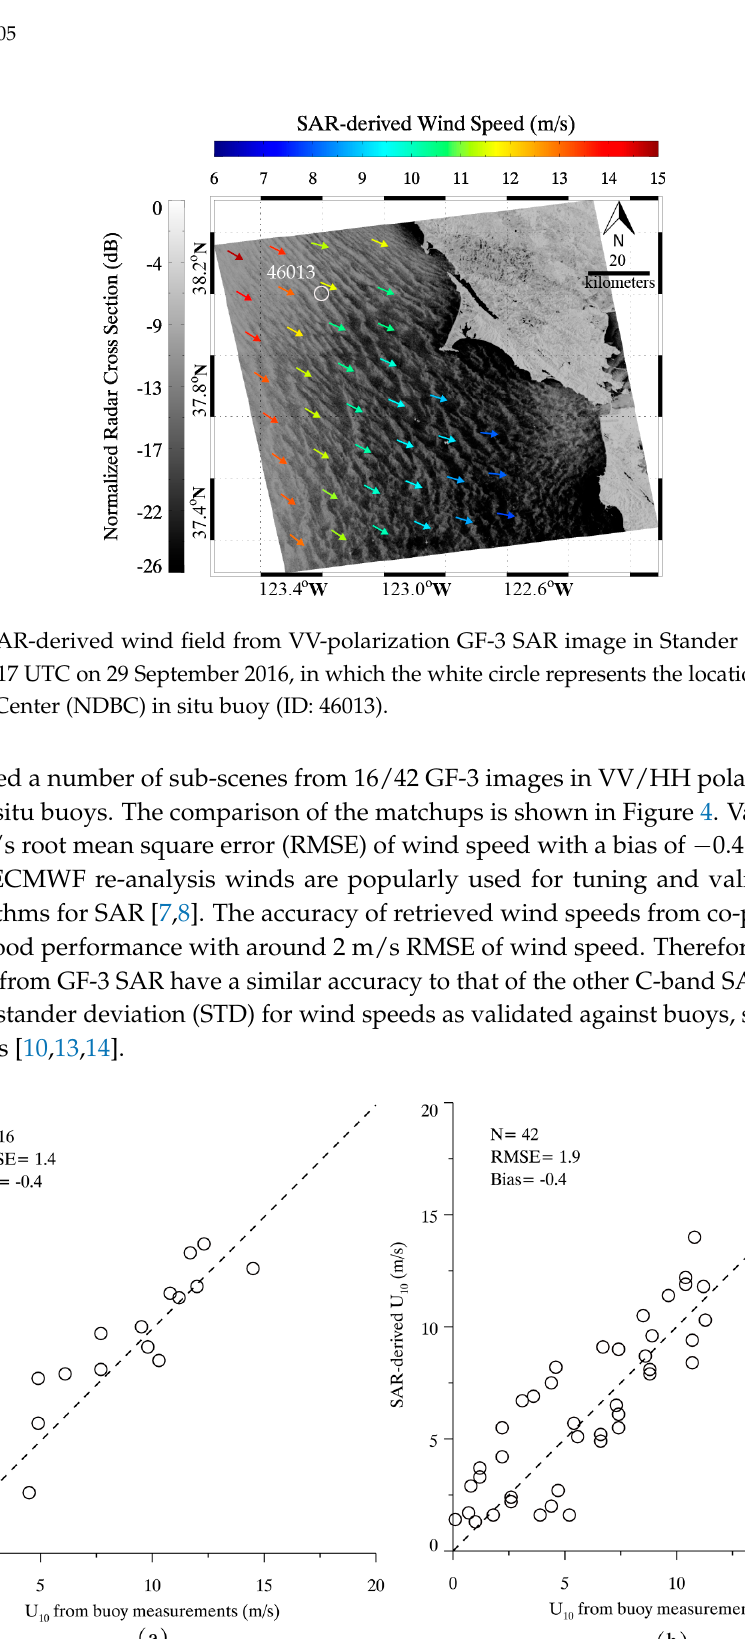
Figure 4. The comparison between SAR-derived wind speed U 10 and measurements from NDBC buoys. ( a ) Comparison for 16 VV-polarization GF-3 SAR images; and ( b ) Comparison for 42 horizontal–horizontal (HH)-polarization GF-3 SAR images.